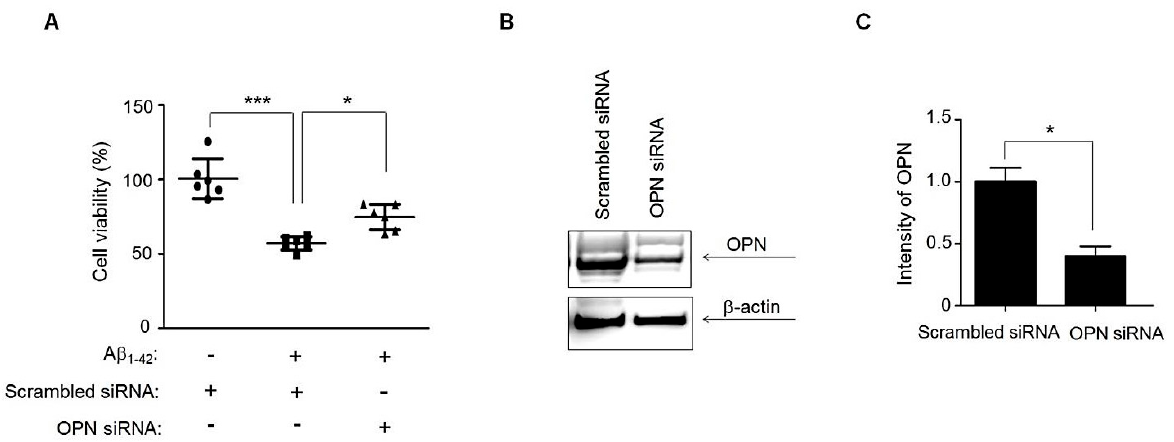
Figure 5. Cell viability of hNSCs cultured in the presence of A β 1–42 with OPN siRNA treatment. ( A ) The viability of hNSCs transfected with OPN siRNA in the presence of 10 μ M A β 1–42 for 24 h was measured by an MTT assay. Mock-treated (lipofectamine only) cells or scrambled siRNA-treated cells were used as controls. The values shown are the mean (SD). For nonparametric multiple compari- son tests, one-way ANOVA was used to determine whether differences between groups were statistically significant. * p < 0.05, *** p < 0.001. ( B ) Western blots of SDS-PAGE gels of hNSCs transfected with OPN siRNA in the presence of 10 μ M A β 1–42 using a primary anti-OPN antibody at 24 h after culture. β -actin was used as a loading control. ( C ) The values shown are the mean (SD). The signifi- cance of differences between two different samples was determined with Student’s t-test. * p < 0.05. All data are representative of two or three independent